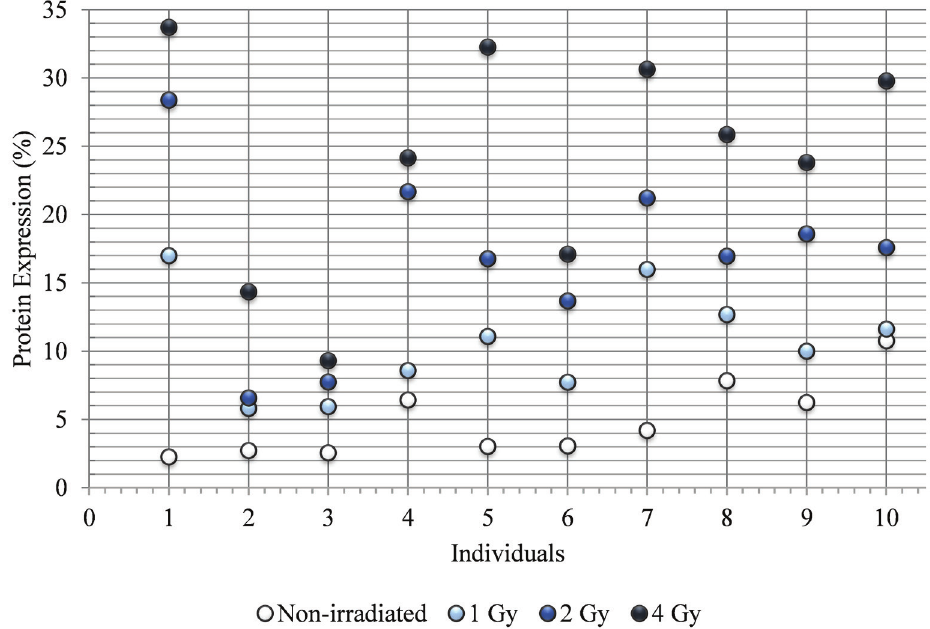
Figure 4 - Individual active caspase-3 expression on lymphocytes incubated for 24 h, for non-irradiated and 1 Gy-, 2 Gy- and 4 Gy-irradiated